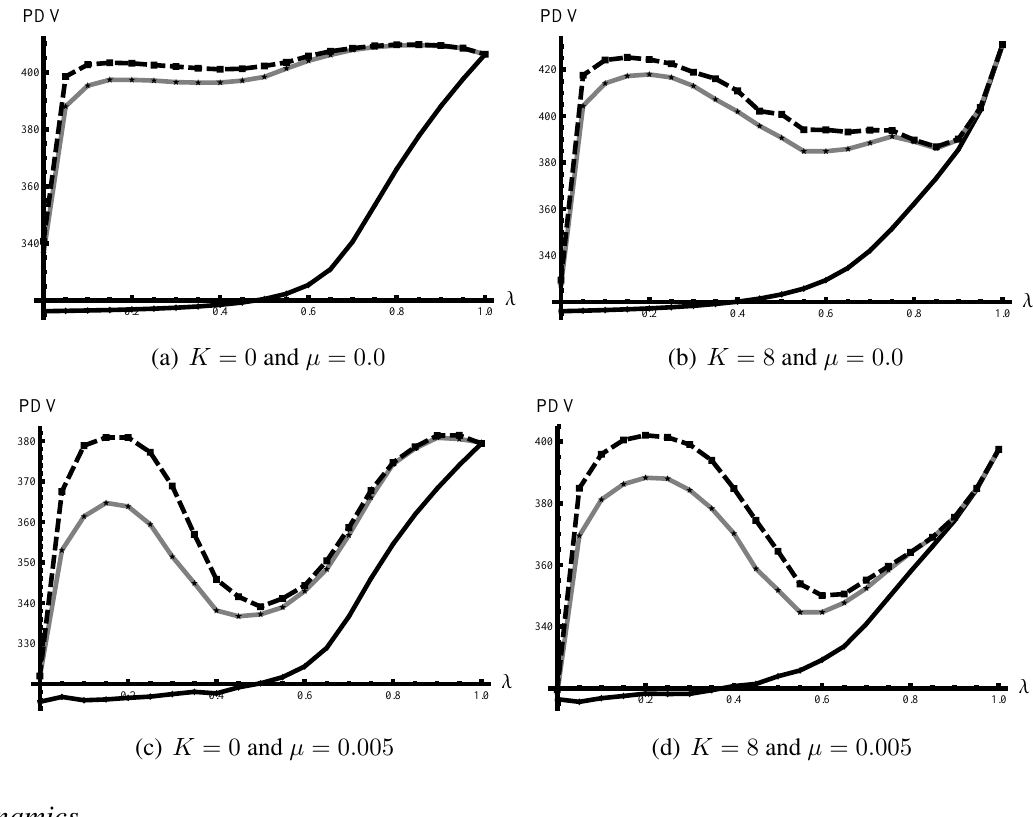
Figure 2. Average PDVs of organizational performances for various λ in four combinations of task complexity ( K = 0 ( left ) and K = 8 ( right )) and environmental turbulence ( µ = 0 . 0 ( top ) and µ = 0 . 005 ( bottom )). In each figure, results for three distinct p s are reported: p = 0 . 0 (solid black), p = 0 . 5 (solid gray) and p = 1 . 0 (dashed black). The discount factor is δ = 0 . 999 . Data are generated by taking an average over 500 simulation